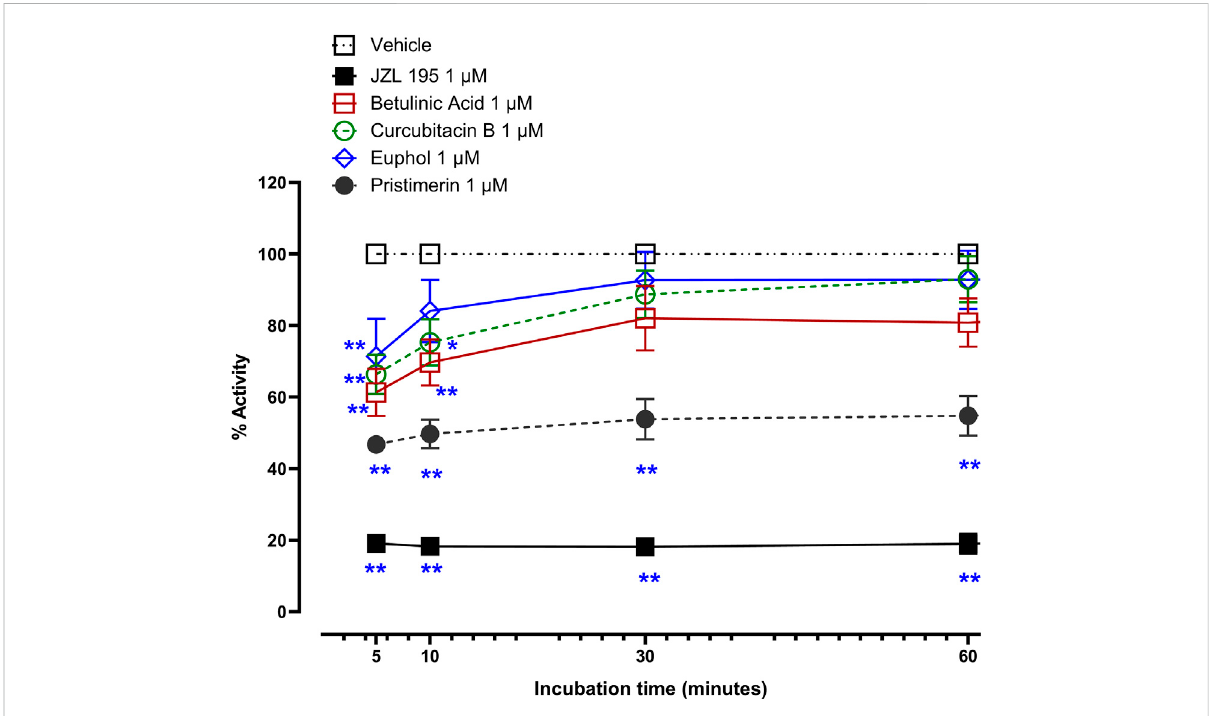
FIGURE 2 Inhibitory effects of 1 µM betulinic acid, cucurbitacin B, euphol, pristimerin and JZL195 on human recombinant MAGL activity over time. Each point represents the mean ± SEM of values obtained from 3 experiments. * p < 0.05, ** p < 0.01 compared to drug vehicle at the same time after treatment (two-way repeated measures ANOVA followed by Dunnett ’ s multiple comparisons